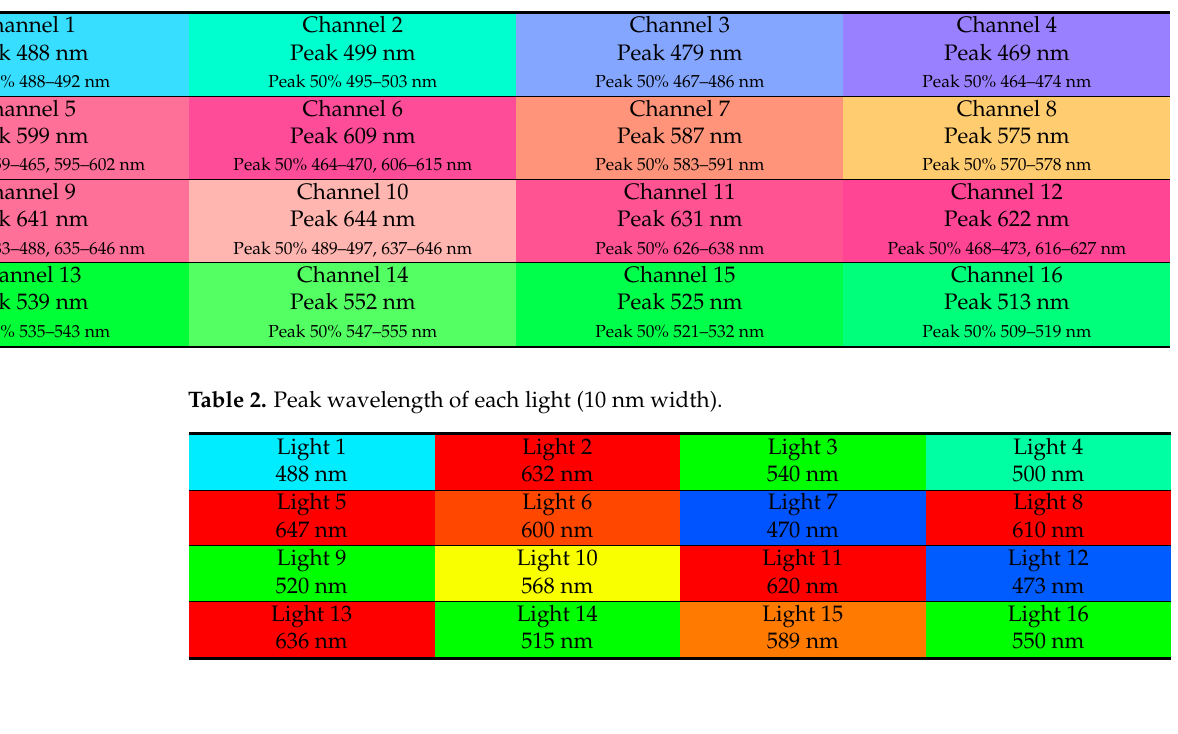
Figure 7. Spectral response of the camera. Table 1. The spectral response for each channel of the camera.